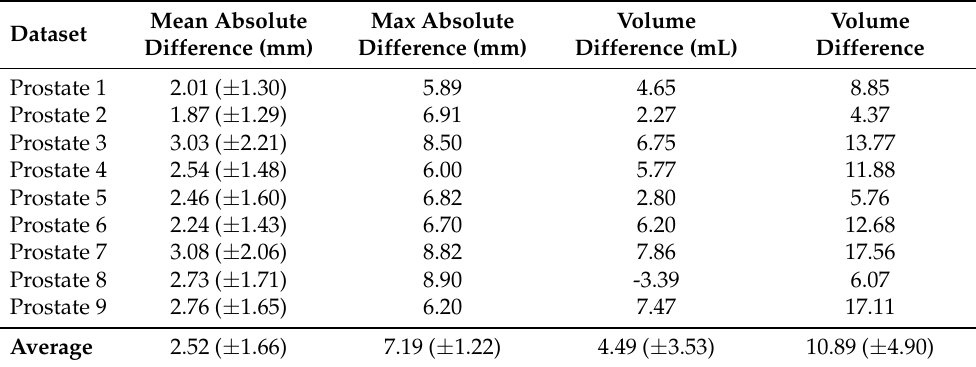
Table 2. Prostate segmentation contour results.